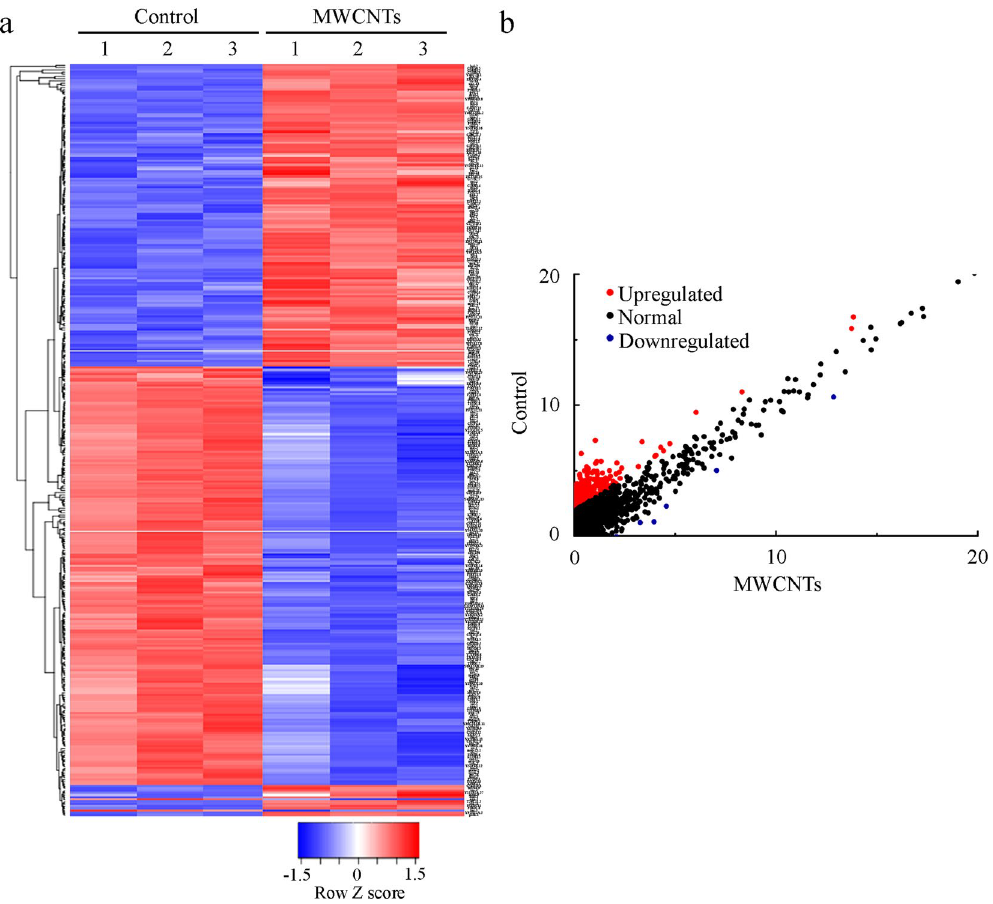
Figure 2. Dysregulated mRNAs induced by MWCNTs. ( a ) Heatmap showing the expression of mRNAs obtained from control and MWCNTs exposed nematodes. Relatively low expression levels are represented as blue, and relatively high expression levels are represented in red. ( b ) Scatter diagram of relationship between mRNA coverage of the control group and the MWCNTs exposure group. Prolonged exposure was performed from L1-larvae to adult day 1. MWCNT exposure concentration was 0.1 μ